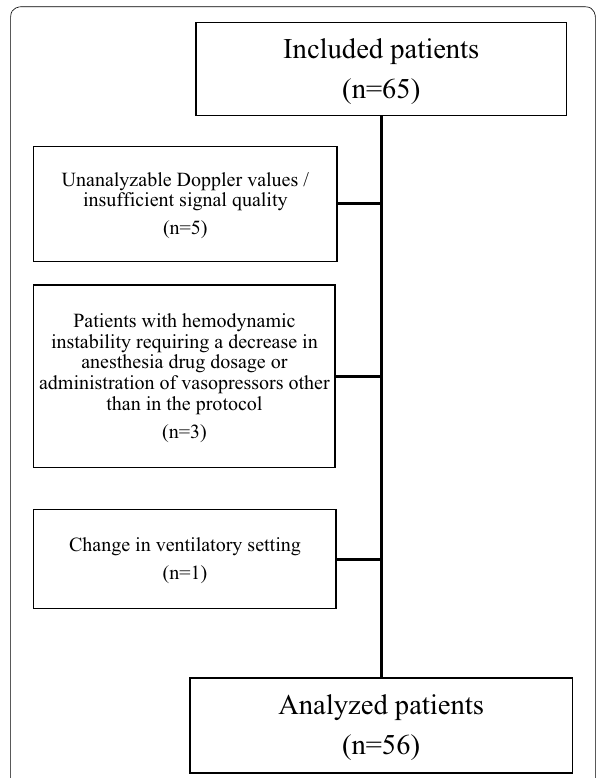
31% ( 40 Fig. 1 Flowchart of patients screened and included in the study − −